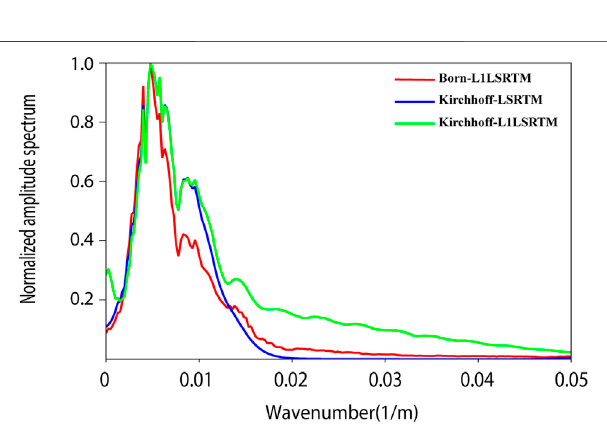
red one is generated from the image inverted by L1-regularized LSRTM based on Born approximation. The blue and green spectrum curves are produced by unconstrained and constrained LSRTM with Kirchhoff approximation, respectively. Because of the spatial